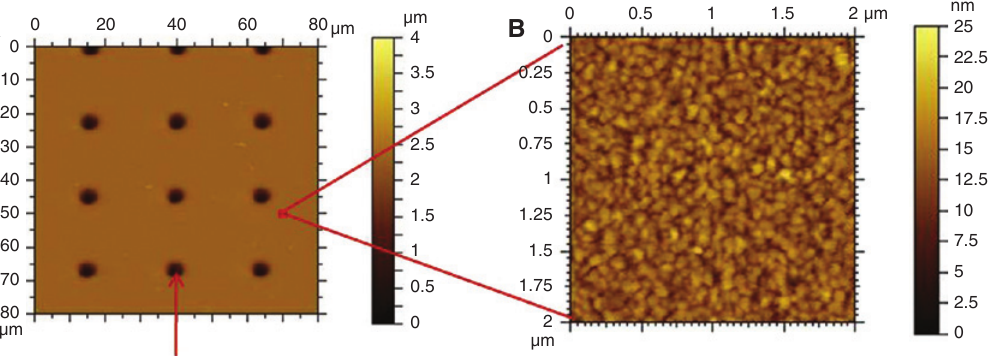
Figure 4: AFM images of plane-recessed microelectrode arrays. (A) Large-scale observation of plane-recessed MEAs; (B) zoom at morphol- ogy of top plane